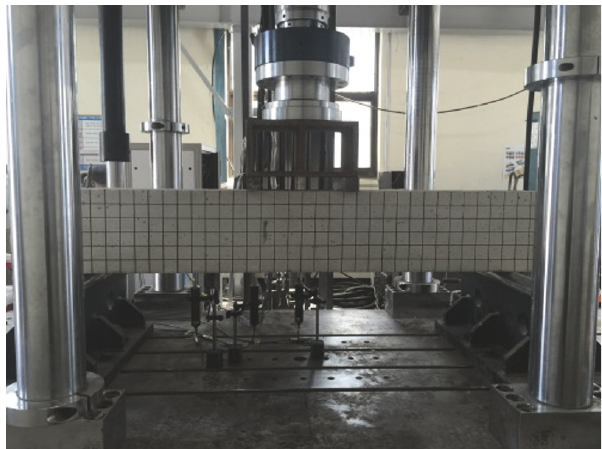
Figure 3: Setup for flexural test of AAS concrete beam